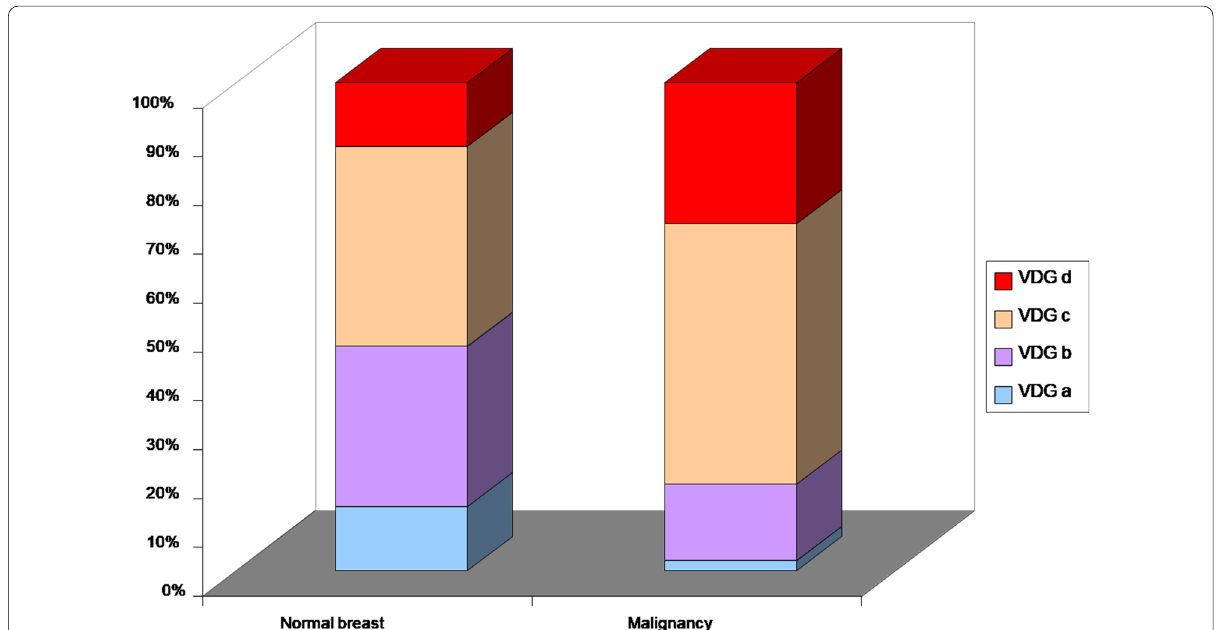
Fig. 4 Bar chart shows comparison of the distribution of normalcy and malignancy among different volumetric density grades (VDG) in study population